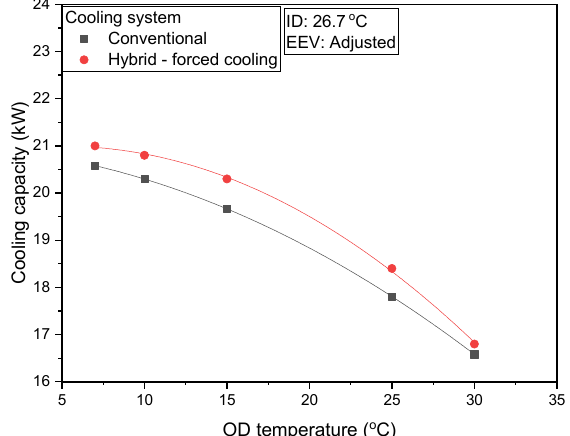
Figure 8. Cooling capacity comparison for novel hybrid IDC cooling and conventional IDC cooling system.